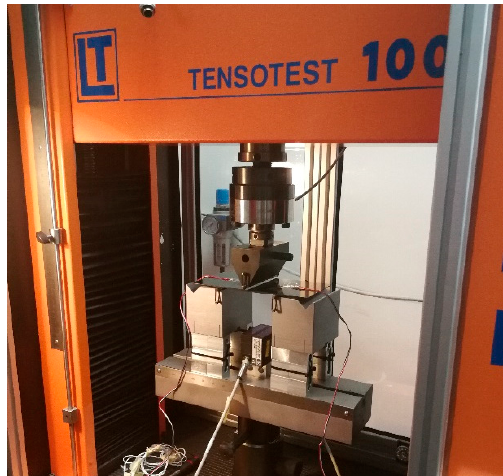
Figure 4. Experimental test rig.